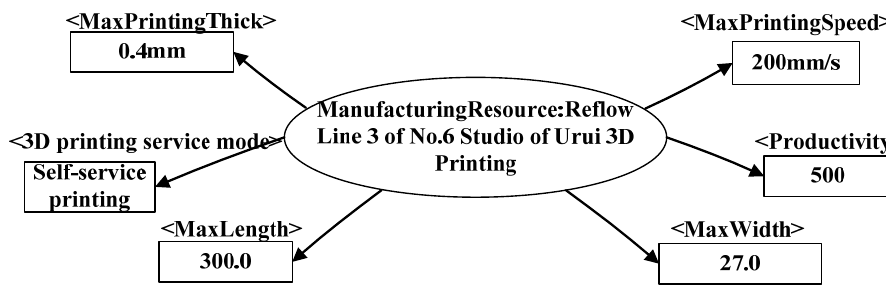
Figure 4. The relationship diagram of C3DPS node.